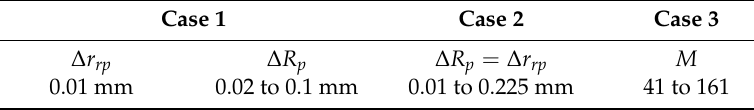
Table 6. Modification conditions.